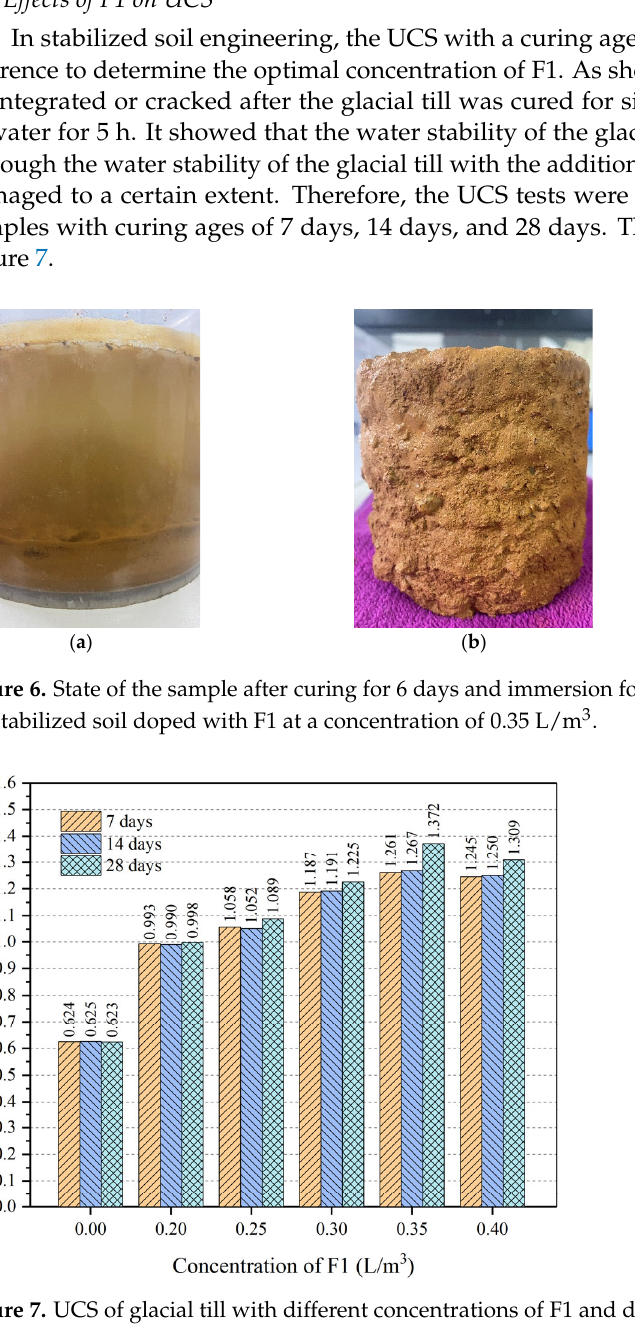
Figure 7. UCS of glacial till with different concentrations of F1 and different curing ages.